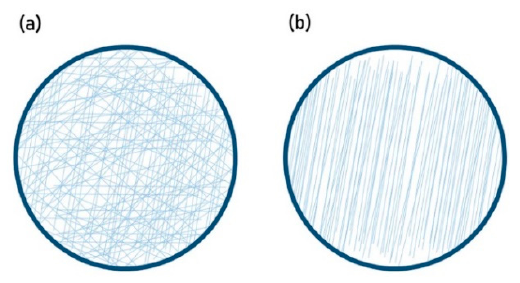
Figure 2. ( a ) Random and ( b ) unidirectional fibre arrangements as a schematic.